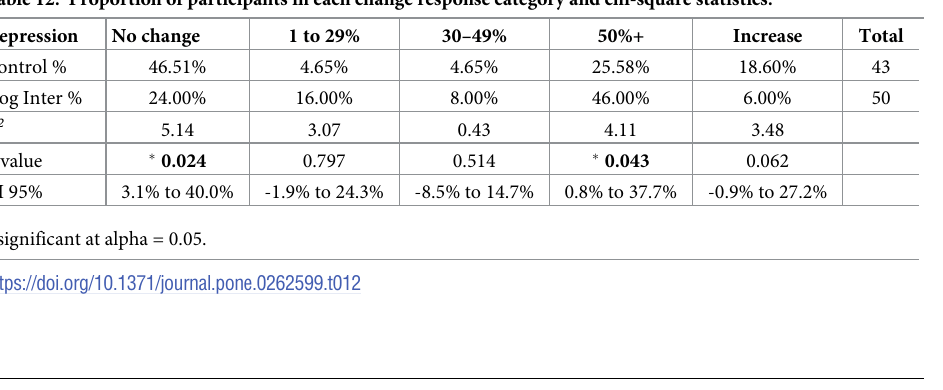
Note .—MS = Mean squares, effect size = partial η 2 .